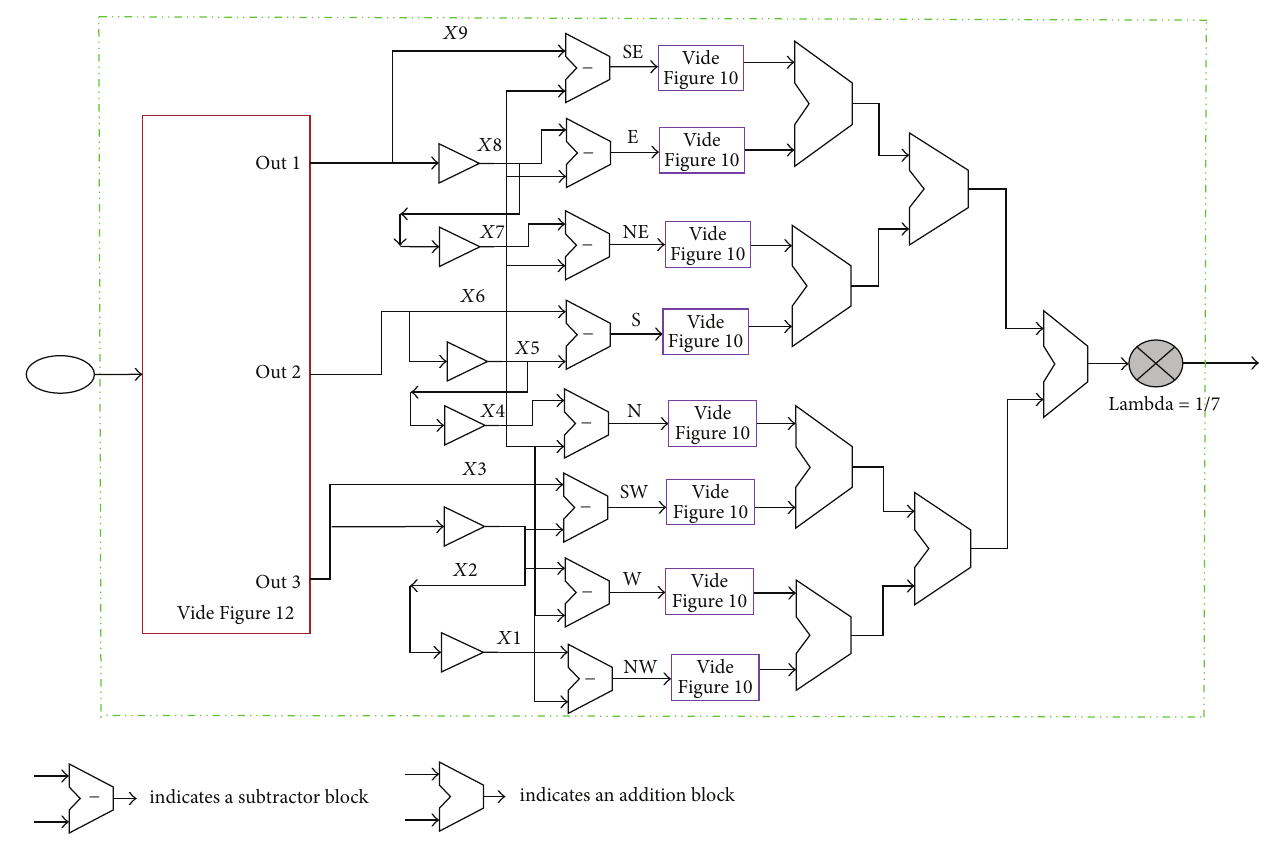
Figure 8: Hardware architecture of the second additive term of the RHS of